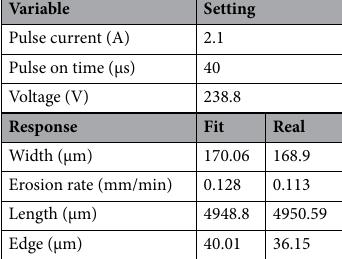
Table 3. Multiple response prediction.